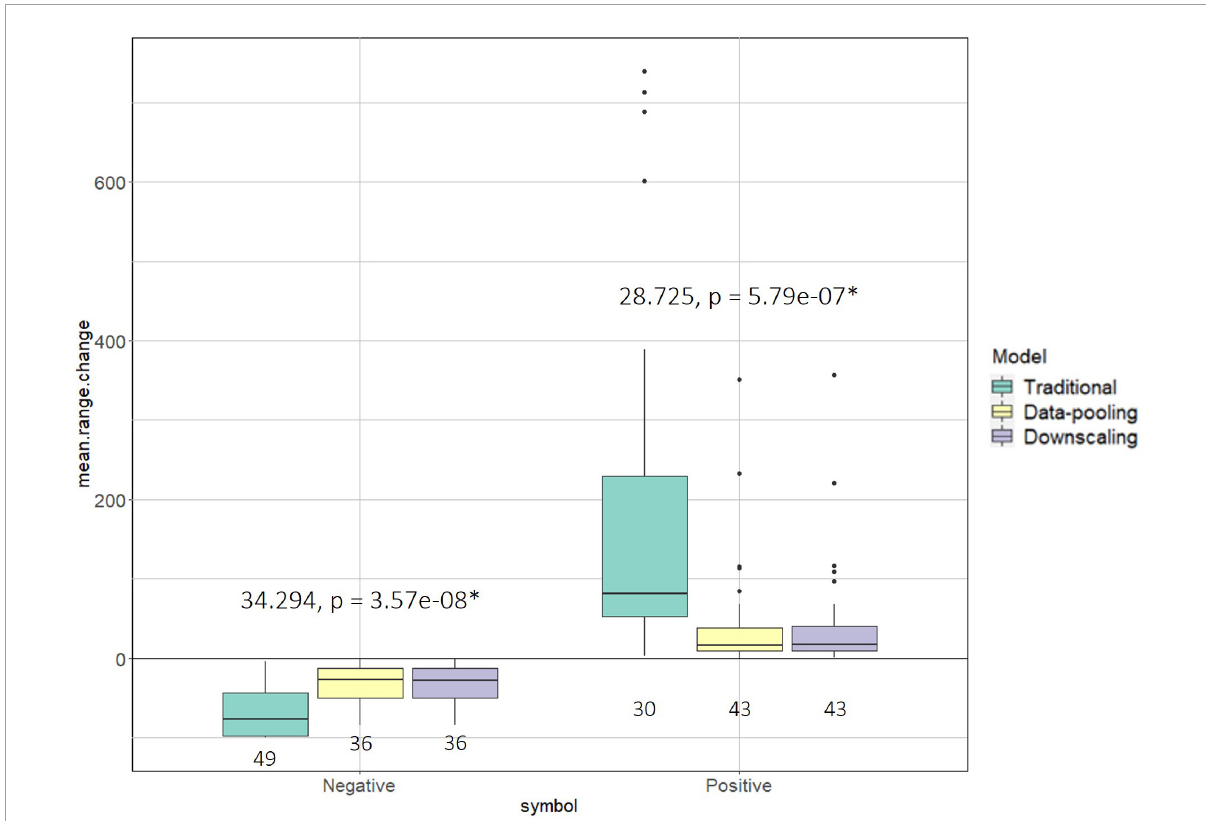
FIGURE3 Boxplots representing the distribution of the predicted range changes (average over the 100 draws from the Bernouilli distribution) under climate change for all bird species under the three models (traditional, data-pooling, downscaling). To better reflect differences between models, we considered separately losses (negative values) and gains (positive values). For each group the Kruskall-Wallis statistic and its associated p -value are shown, with “ ∗ ” marking significant differences between models. Below each box we also show the number of species (sample size) predicted to reduce (negative) or increase (positive) their